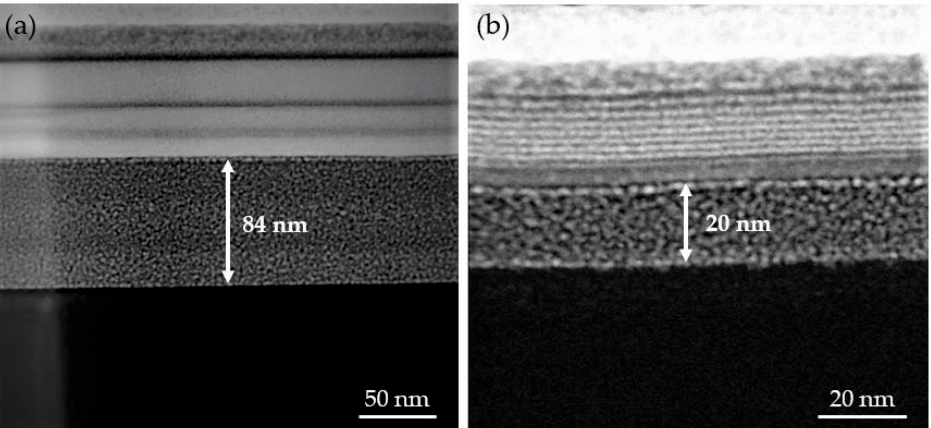
Figure 1. Scanning Transmission Electron Microscopy (STEM) images corresponding to two different Pt-C cryo-deposits grown at substrate temperature of − 100 °C and 30 keV ion beam voltage under: ( a ) Non optimized and ( b ) optimized conditions with respect to the GIS opening time, the GIS-substrate distance and the GIS precursor temperature (see the main text for the exact deposition conditions in both cases). The Ga + irradiation area doses used for the 84 nm-thick and 20 nm-thick deposits were 144 μ C/cm 2 and 120 μ C/cm 2 , respectively.